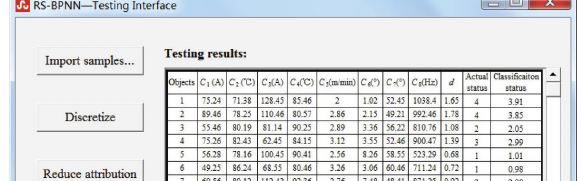
Table 3: The discretized decision table.